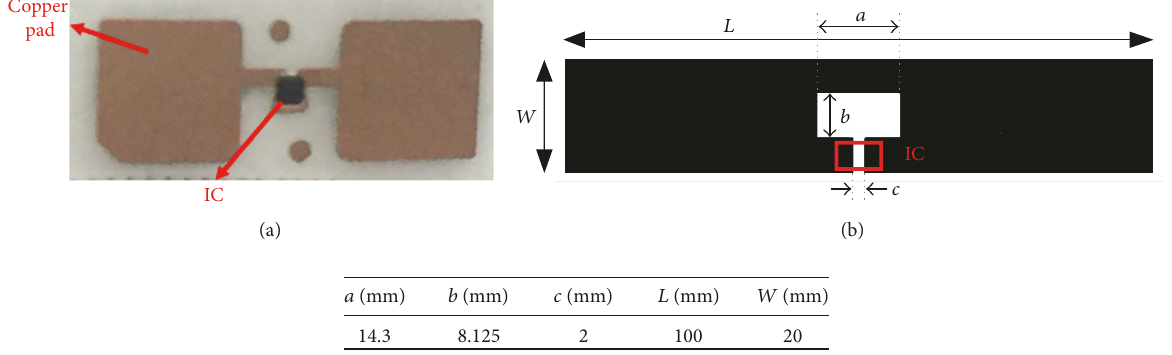
Figure 1: The IC strap (a) and the tag antenna structure (b).